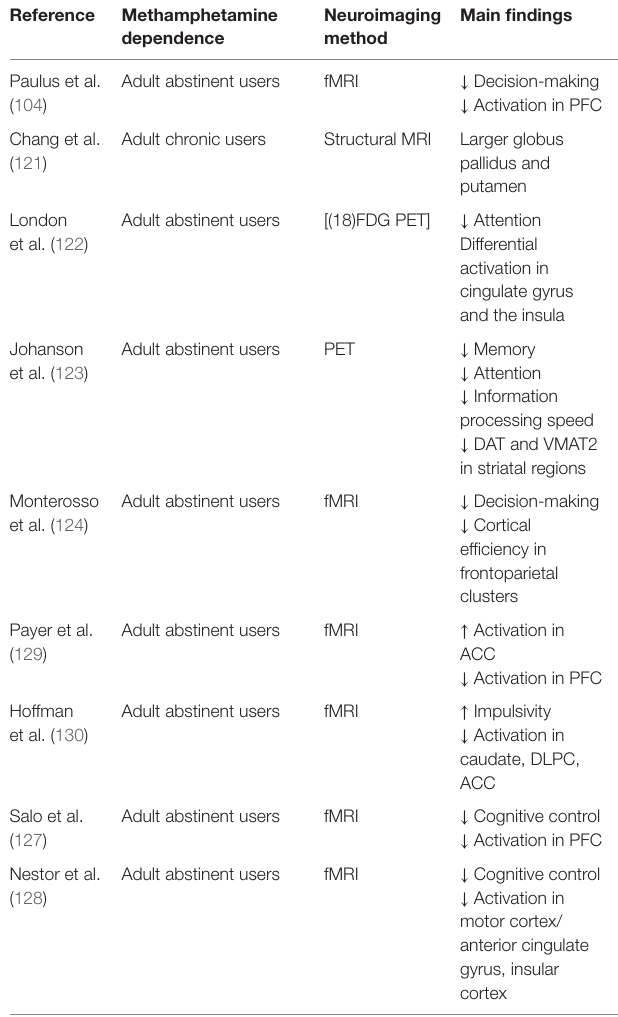
TABLe 5 | Cognitive deficits reported in methamphetamine users.